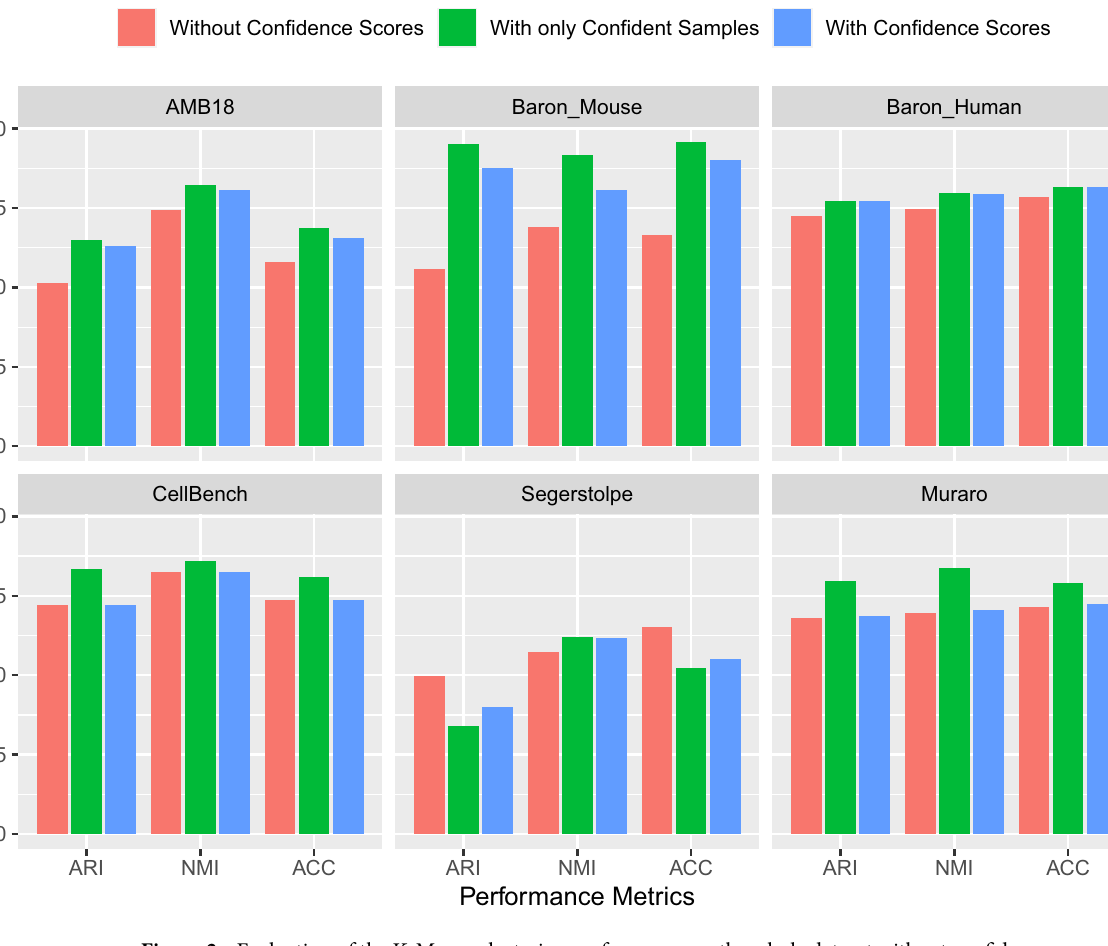
Figure 2. Evaluation of the K-Means clustering performance on the whole dataset without confidence scores, on the dataset with only high-confident samples, and on the dataset where the eliminated samples are then positioned on the existing clusters, respectively. The elimination rate is chosen as 0.4. This elimination rate corresponds to the threshold values of confidence scores of 0.985, 0.824, 0.946, 0.859, 0.825, and 0.873 for the datasets,